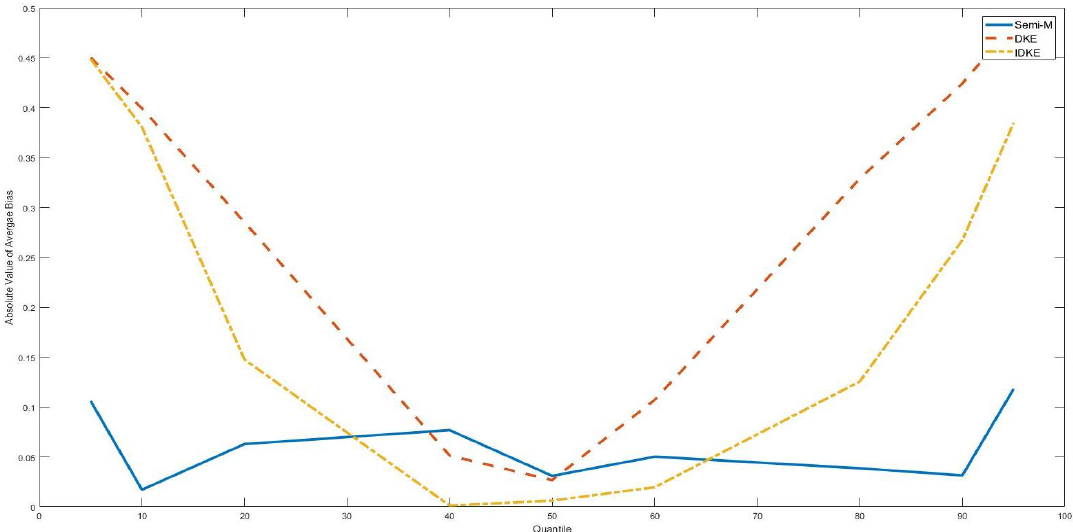
Figure 4. Average bias with γ 0 as various quantiles of the threshold variable, DGP 5, n = 300. This figure shows absolute values of the average bias with the true threshold level being several quantiles of the threshold variable (5th,10th,20th,40th,50th,60th,80th,90th,95th). The simulation is based on DGP 5. The sample size is